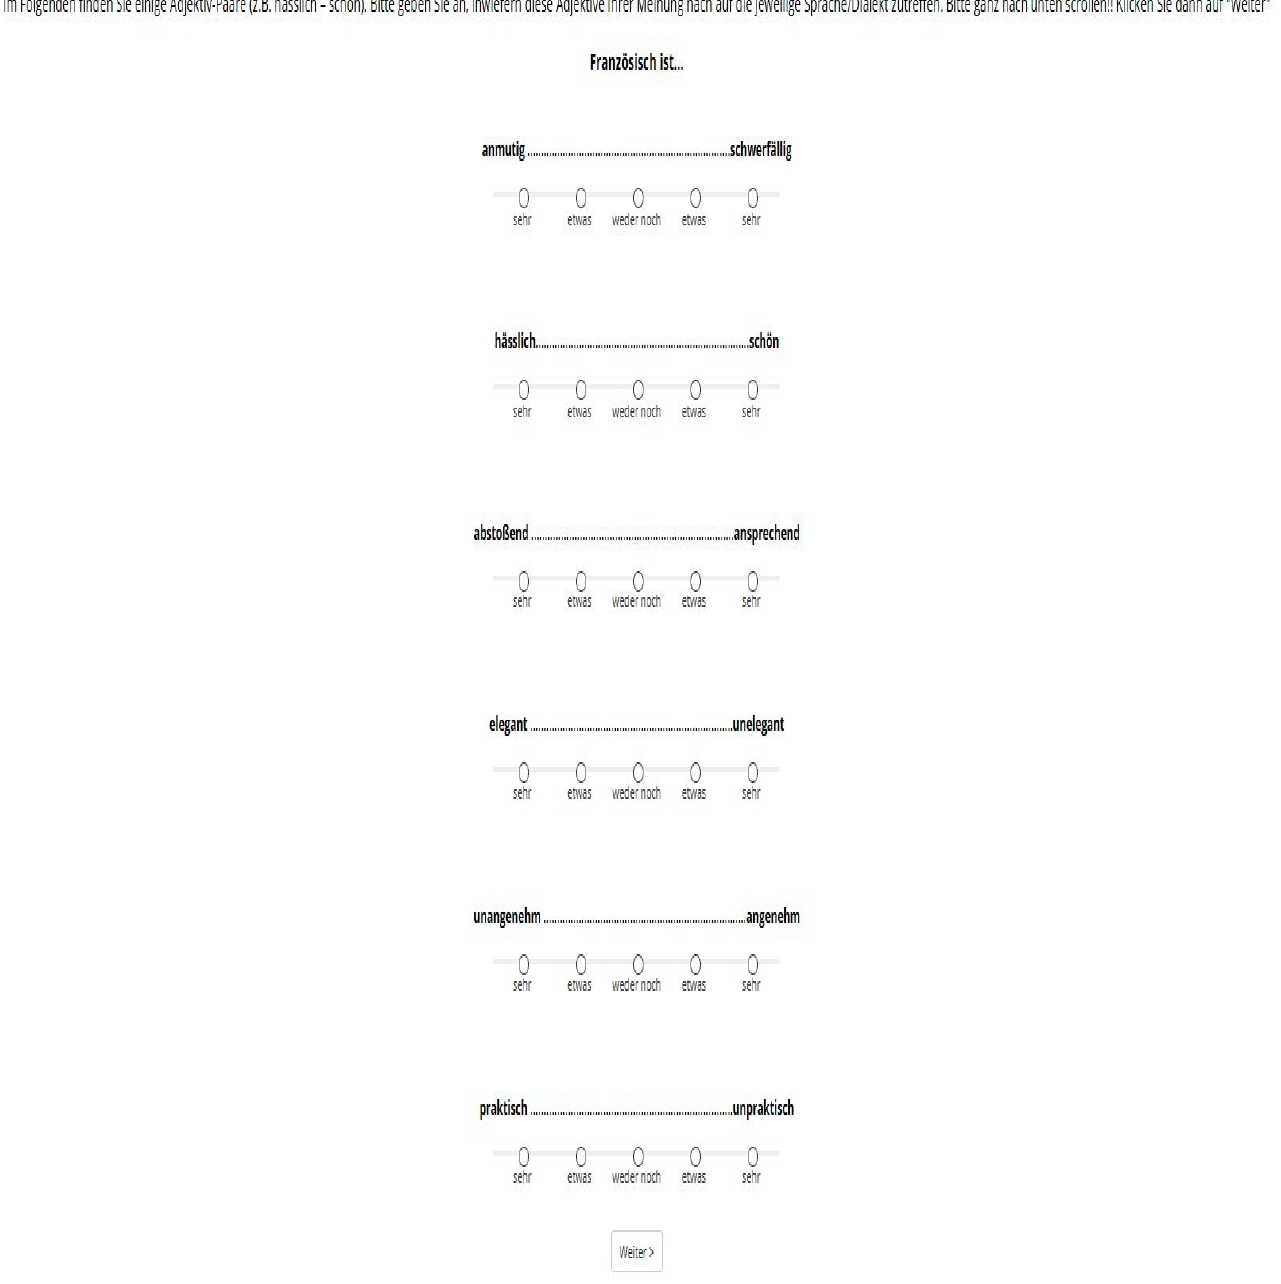
Figure A5. Semantic differential scales to measure attitudes towards French in Belgium and Luxembourg.